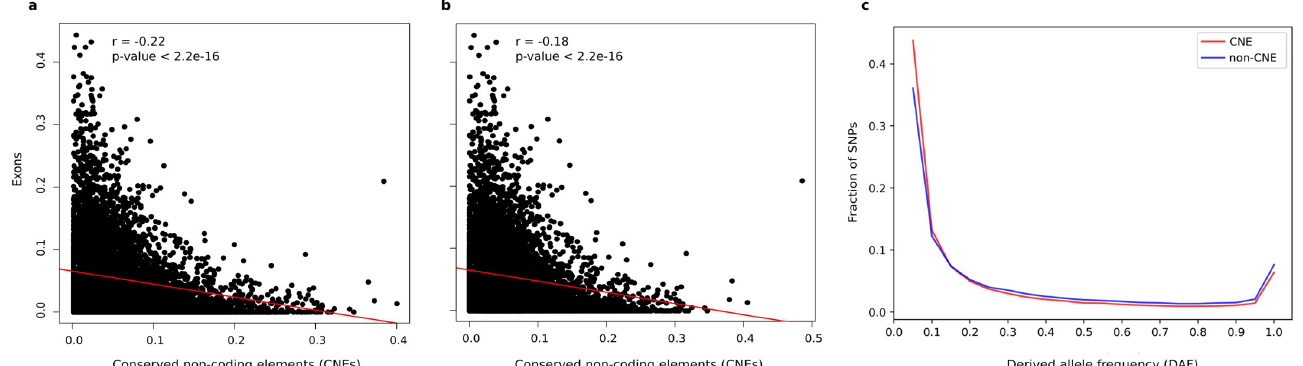
Fig 2. Conserved non-protein-coding elements are less common in gene dense regions and are selectively constrained. Correlation between exons and CNEs along the chicken genome when considering ( a .) and excluding ( b .) coding sequences. CNEs and exon density was calculated in windows of 100 kb. The Pearson correlation coefficient r and corresponding p-value are shown in the top left corner. c . Derived allele frequency (DAF) distribution of SNPs in CNEs and non- CNEs.